Question: How would you classify this visualization?
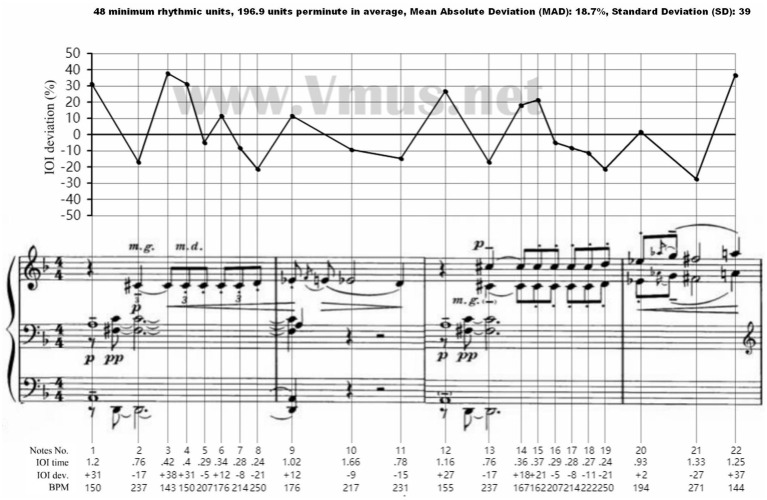
Answer: line